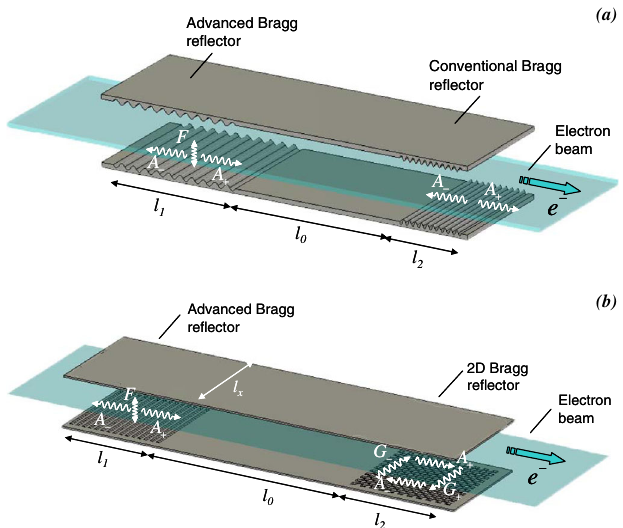
FIG. 1. The schemes of planar FEL with advanced upstream Bragg reflector. As downstream reflectors can be used either conventional (a) or two-dimensional (b) Bragg structures. Arrows mark the directions of